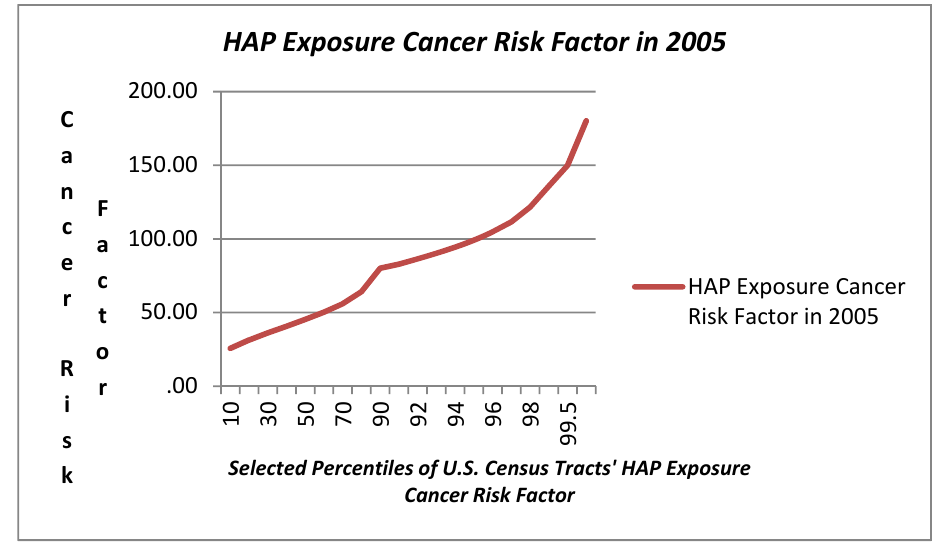
Figure 5. Hazardous Air Pollution (HAP) Cancer Risk Factor Exposure Hazard Index (2005) Values at Selected Percentiles for U.S. Census Tracts (U.S. E.P.A. National Air Toxics Assessment, 2005)